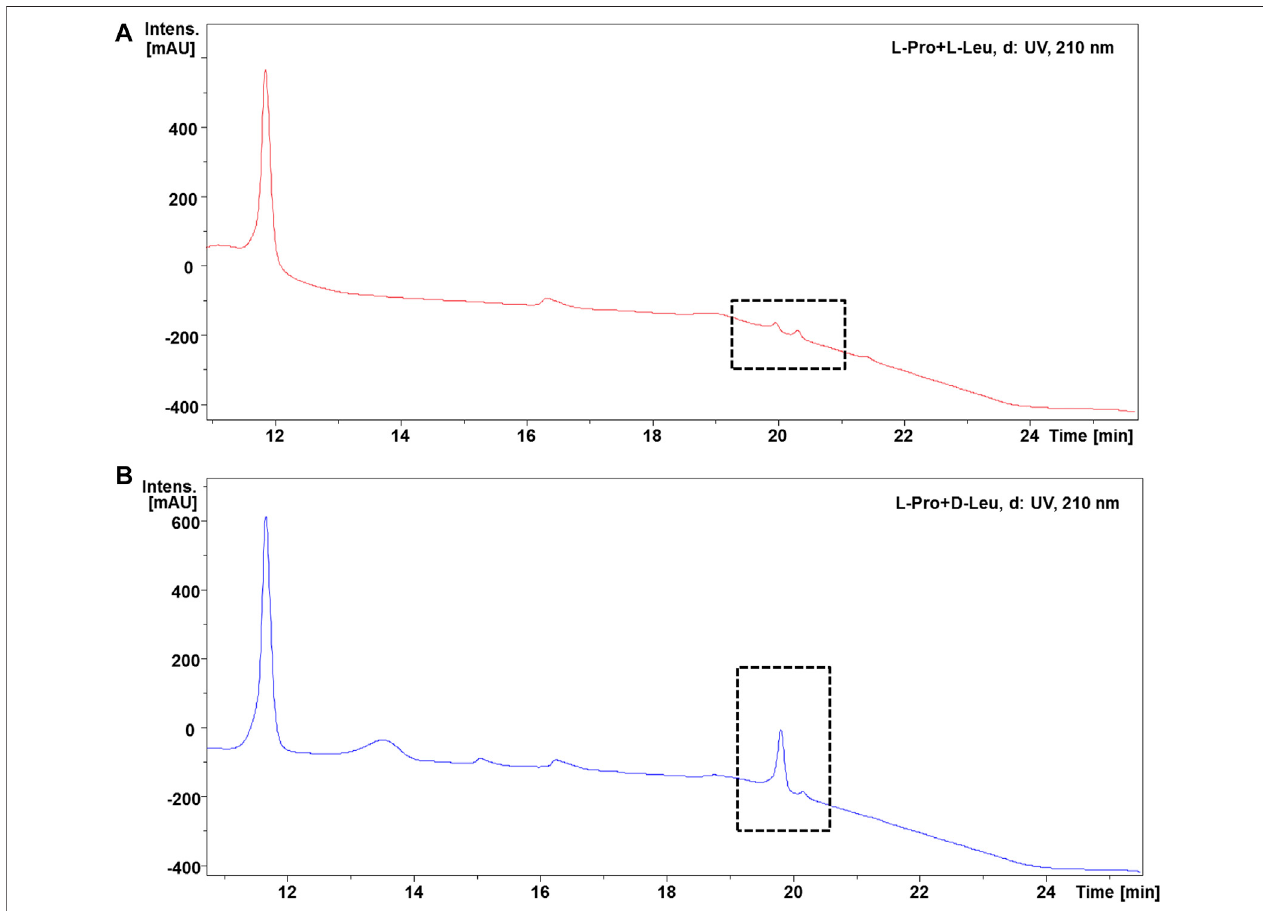
FIGURE 3 | HPLC spectra analysis of cyclo-Pro-Leu products. (A) : HPLC pro fi le for the reaction products cyclo-L-Pro-L-Leu of L-Leu with L-Pro and P 3 m in aqueous solution. (B) : HPLC spectrum of products cyclo-L-Pro-D-Leu from the reaction system with D-Leu, L-Pro and P 3 m. The peaks in the gridlines represent corresponding products cyclo-Pro-Leu. The peak with retention time of 11.9 min was cyclo-Pro-Pro.